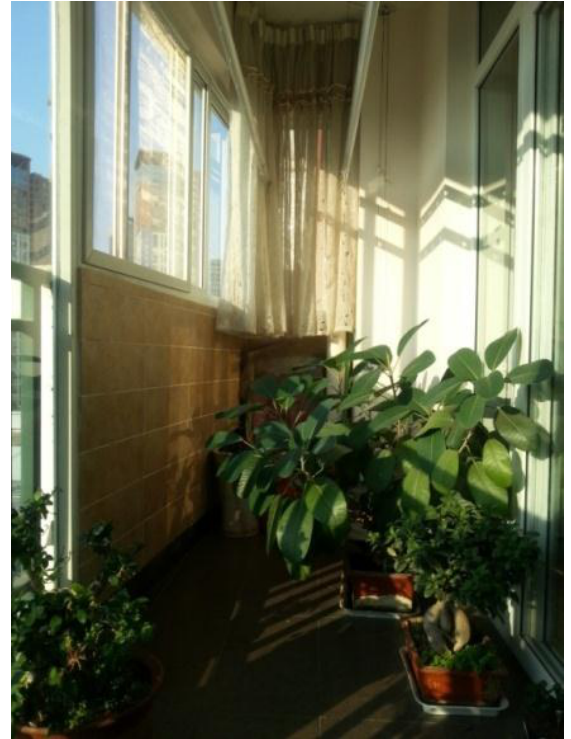
Figure 6. The balcony enclosed as a separate internal